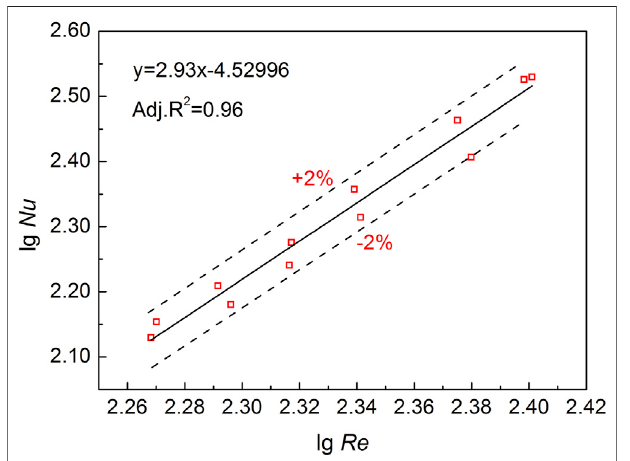
FIGURE 5 | Calculated Nusselt and experimental Nusselt